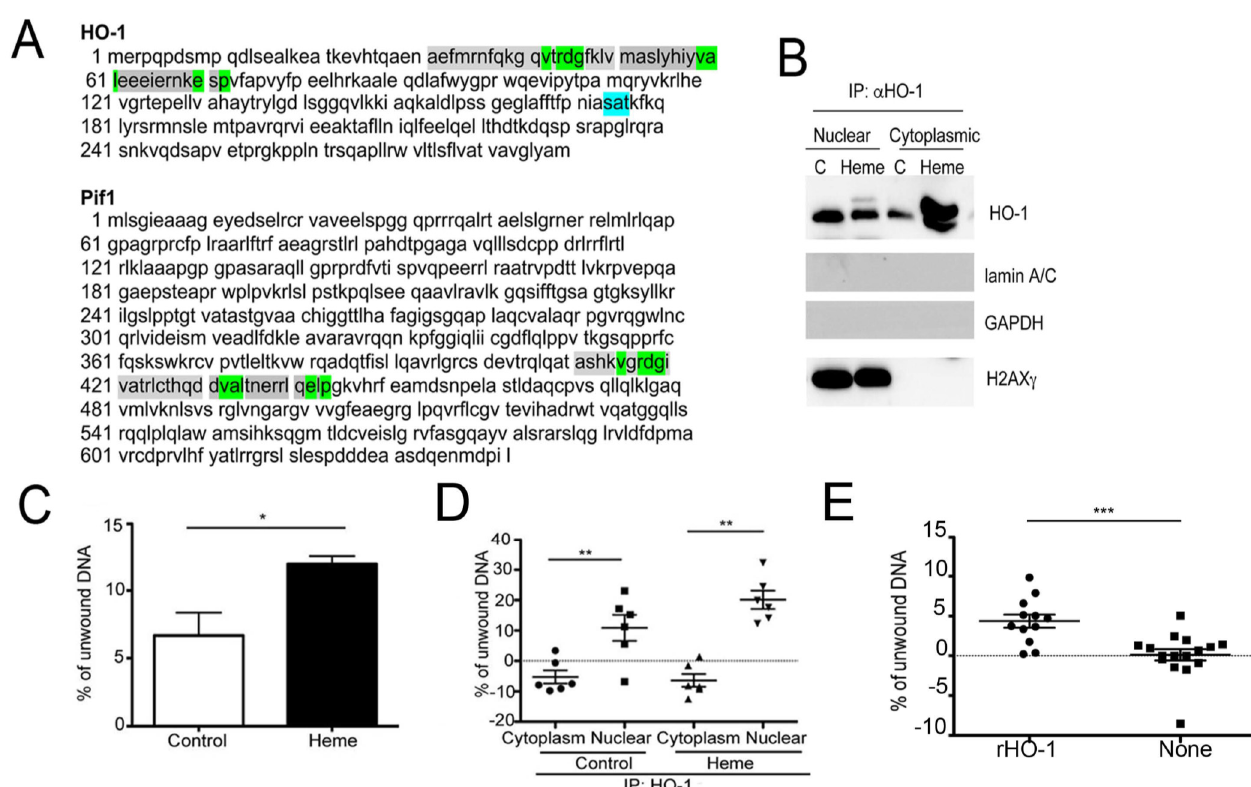
Figure 3. Helicase activity in heme treated cells- role of HO-1. ( A ) Similarities between the HO-1 and Pif1 sequences. The SAT motif of HO-1 is labeled. ( B ) Immunoprecpitation (IP) with antibody against HO-1 ( α -HO-1, 1 μ g) in the nuclear and cytoplasmic fractions of PC3 cells treated with heme (Heme, 50 μ M) or control cells. (C) (24 h). ( C ) Helicase activity assays were performed in the lysates of PC3 cells treated with heme for 24 h as previously described [77]. * p < 0.05. Briefly, 1 μ g sonicated genomic DNA was incubated with 1 mM ATP, 1× Sally Green, 10 g of protein lysates in the helicase buffer (200 mM Tris HCl pH 7.6, 25 mM MgCl2, 20 mM DTT, 125 mM KCl, 10% glycerol, 0.5 mg/mL BSA). Reactions were incubated at 37 °C for 30 min and fluorescence was measured at 492 and 530 nm. Percent of unwound substrate was calculated as described in [77]. ( D ) Helicase activity assays were performed in the immunoprecipitates of HO-1 in the nuclear and cytoplasmic fractions of PC3 cells treated with heme for 24 h. ** p < 0.01. n = 3 biological replicates. ( E ) Helicase activity of the recombinant HO-1 (Enzo Life Sciences) using 1 g of recombinant protein in the helicase assay as described above. *** p < 0.001.